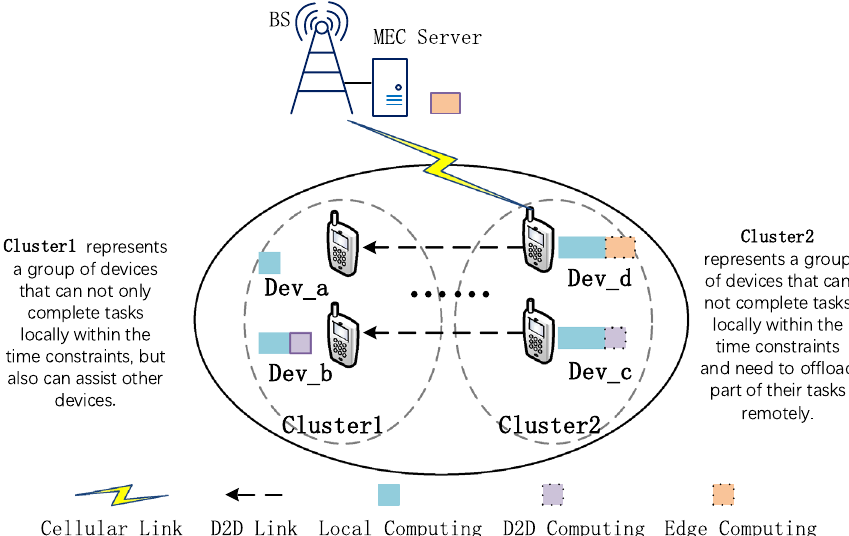
Figure 1. D2D-assisted MEC system. Local/D2D/Edge computing means the tasks executed via the corresponding mode.